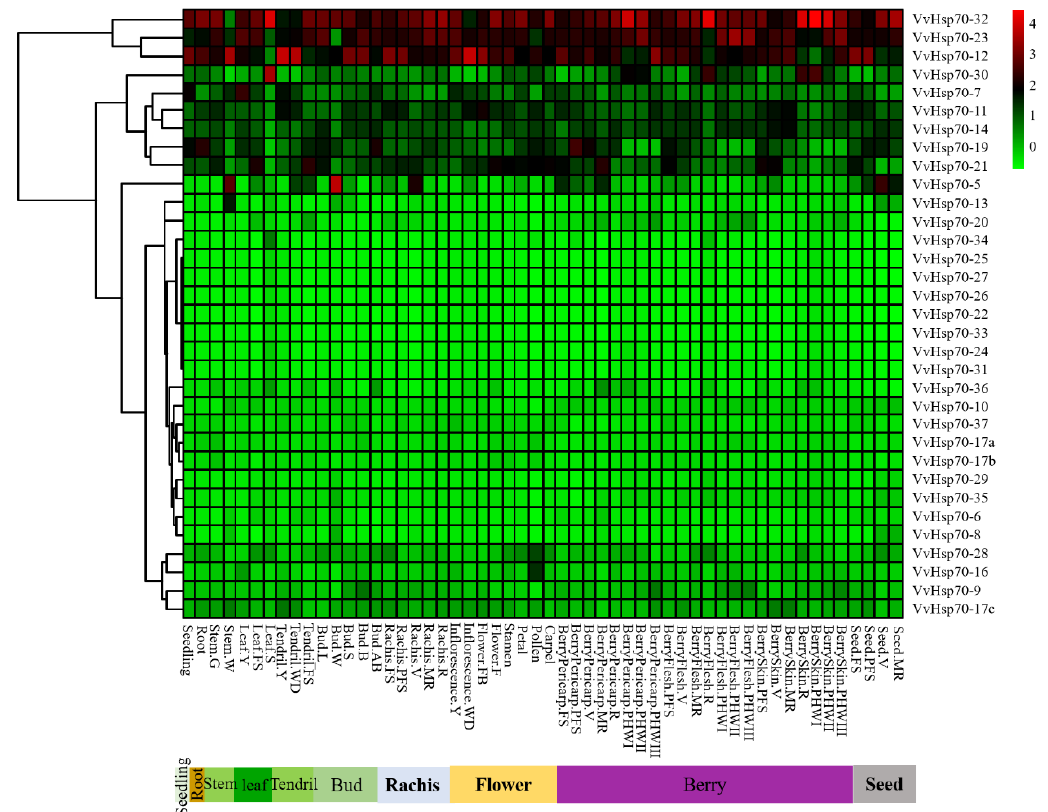
Figure 5. Expression analysis of VvHsp70 genes in different tissues and development stages based on GSE36128. The color scale represents relative expression level. Detailed tissue information is described in Table S3 [30].